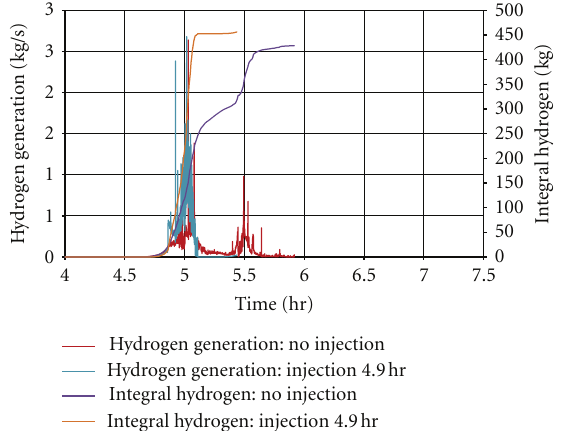
Figure 38: Hydrogen generation rate and integral hydrogen for scenarios without water injection and with water injection at 4.9 hours after scram (all emergency water injection was terminated at 4.2 hours after reactor